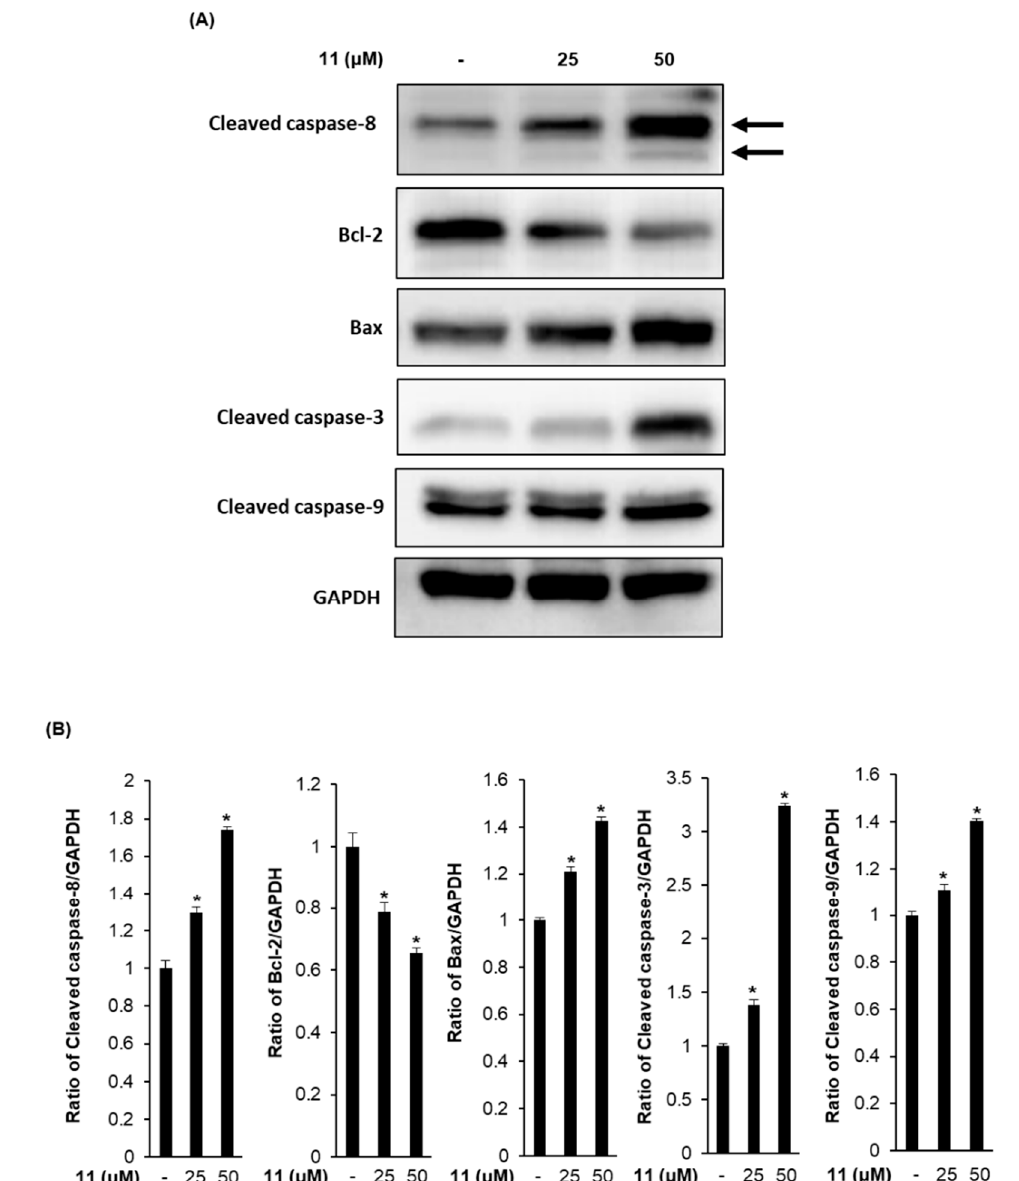
Figure 5. Effects of compound 11 on the expression of apoptosis-related proteins in A2780 human ovarian carcinoma cells. ( A ) A representative western blot is shown demonstrating the levels of cleaved caspase-8, Bcl-2, Bax, cleaved caspase-3, cleaved caspase-9, and glyceraldehyde-3-phosphate dehydrogenase (GAPDH) in A2780 cells treated with compound 11 (25 and 50 μ M). GAPDH was used as an internal control. ( B ) Each bar graphs represents the densitometric quantification of western blot bands. * p < 0.05 compared to the values obtained for non-treated cells. Western blot assays were done in triplicate for each protein and were repeated at least three times.